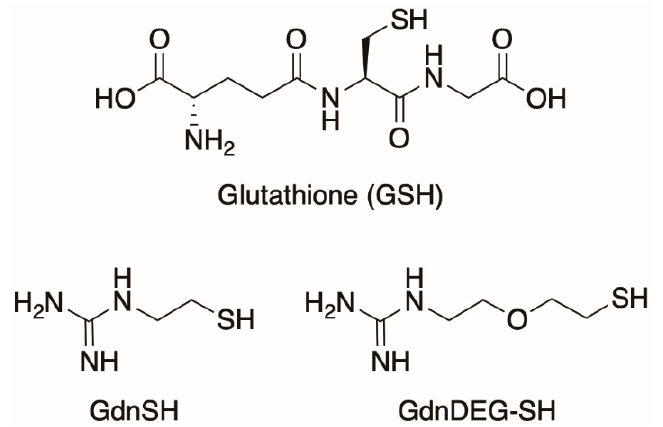
Figure 1. Molecular structures of glutathione (GSH), thiol–guanidyl conjugate without the spacer Figure 1. Molecularstructuresofglutathione(GSH),thiol–guanidylconjugatewithoutthespacer(GdnSH), (GdnSH), and conjugate between thiol and guanidyl units with a diethylene glycol spacer and conjugate between thiol and guanidyl units with a diethylene glycol spacer (GdnDEG-SH).